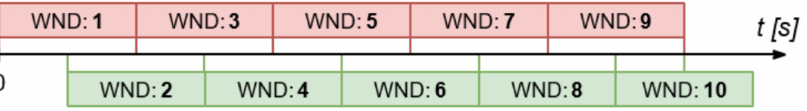
Figure 13. Sliding window disposition for regression process with signals from the MIMIC III database.